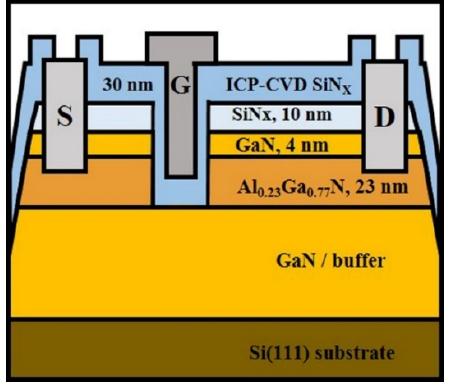
Figure 1. The cross-sectional view of the fabricated device. (S = Source, G = Gate, D = Drain, ICP-CVD = Inductively coupled plasma-chemical vapor deposition).